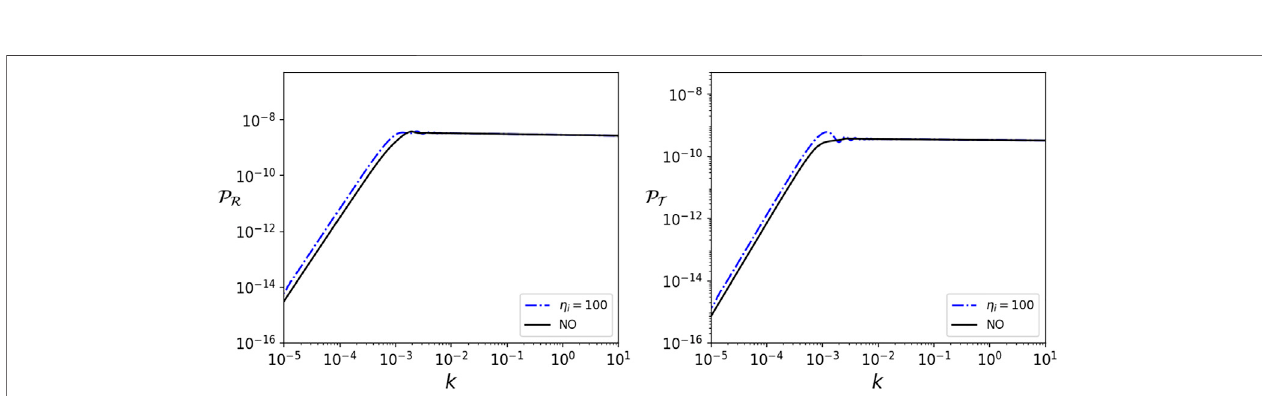
FIGURE 4 | Comparison between the power spectra of the comoving curvature perturbation P R and tensor perturbation P T corresponding to the SLE obtained with η 0 (cid:1) 100(dotted-dashedblueline)andtotheNOvacuum(solidblackline).Thescaleof k isinPlanckunits.Allcomputationswereperformedforaquadraticpotential V ( ϕ ) (cid:1) m 2 ϕ 2 /2, with m (cid:1) 1.2 × 10 − 6 and with the value of the scalar fi eld at the bounce fi xed to ϕ B (cid:1) 1.225 (toy value).